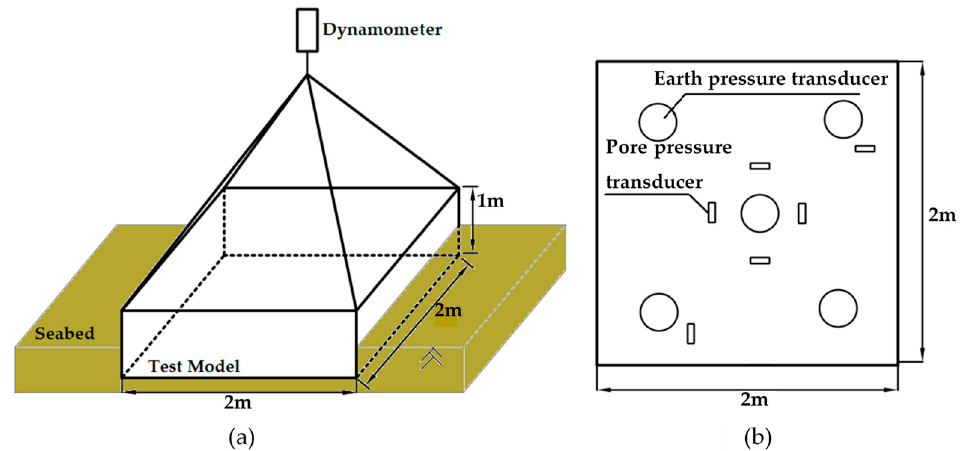
Figure 2. ( a ) Overall and ( b ) bottom schematic diagram of the bottom-supported model foundation.